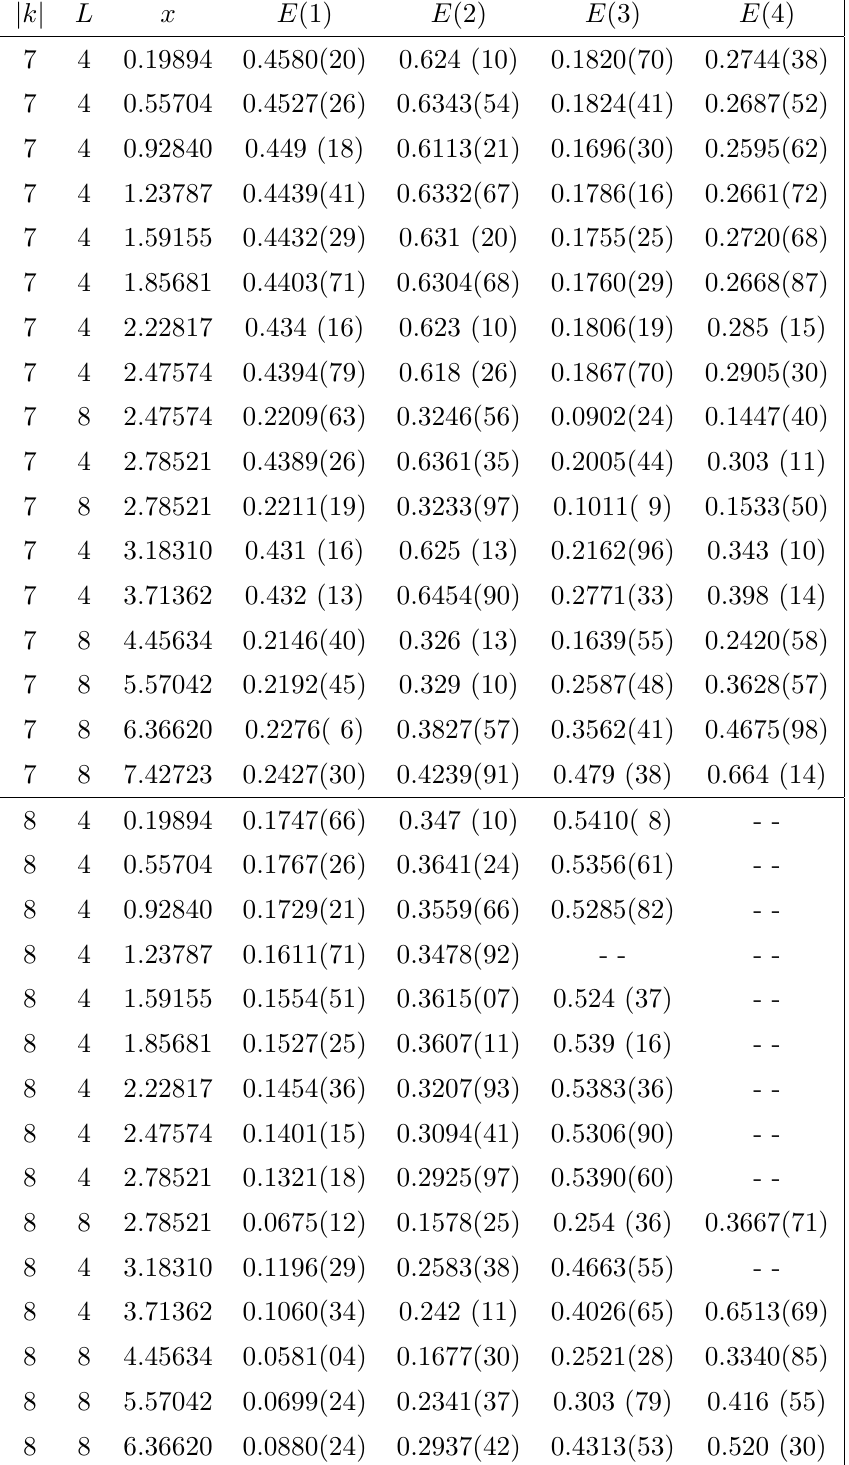
Table 12. SU(17) torelon energies (in lattice units)